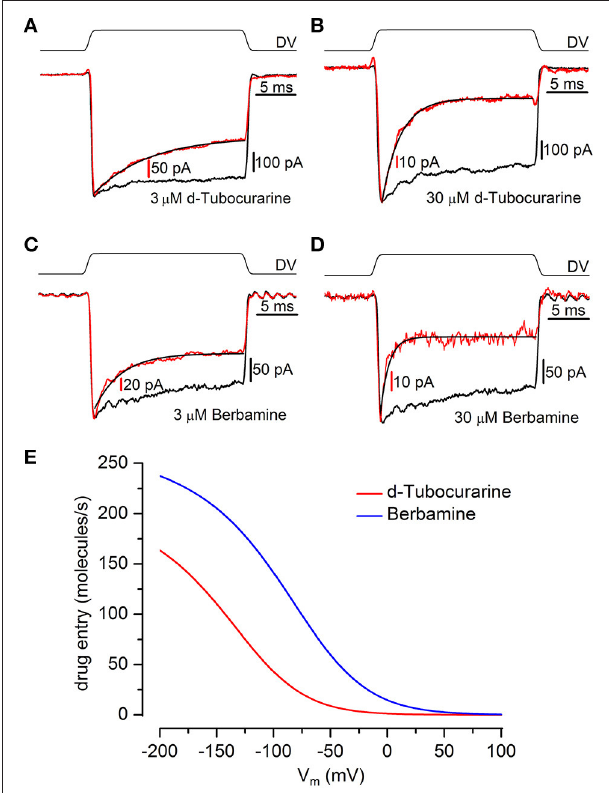
FIGURE 9 | Kinetics of MET channel block reveal d-tubocurarine and berbamine act as open channel blockers. (A–D) Transducer currents were recorded from OHCs in response to a mechanical step delivered by a fluid-jet ( ± 40 V driver voltage, DV), shown above each trace [ (A,B) P2 + 2; (C,D) P2 + 3]. From a holding potential of − 84 mV, cells were exposed to an initial saturating inhibitory stimulus, resulting in the closure of the MET channels, followed by a saturating excitatory step eliciting rapidly activating inward currents. Currents (averaged from 10 repetitions) before (black trace) and during (red trace) superfusion of 3 µ M dTC (A) , 30 µ M dTC (B) , 3 µ M berbamine (C) , and 30 µ M berbamine (D) were scaled and superimposed. Maximum transducer currents were; (A) − 679 pA before and − 369 pA during 3 µ M dTC application, (B) − 742 pA before and − 137 pA during 30 µ M dTC application, (C) − 271 pA before and − 211 pA during 3 µ M berbamine application and (D) − 271 pA before and − 67 pA during 30 µ M berbamine application. Both dTC and berbamine can be seen to act as open channel blockers from the decline in current size observed following the excitatory step. The currents during compound superfusion were fitted with single exponentials (A) τ = 6.9 ms (B) τ = 2.1 ms (C) τ = 3.2 ms (D) τ = 0.83 ms. (E) Entry rates into the OHC of extracellular dTC and berbamine as a function of membrane potential. At all membrane potentials berbamine enters the cell more rapidly than dTC. Rates calculated for 1 µ M compound, 80 channels, p open